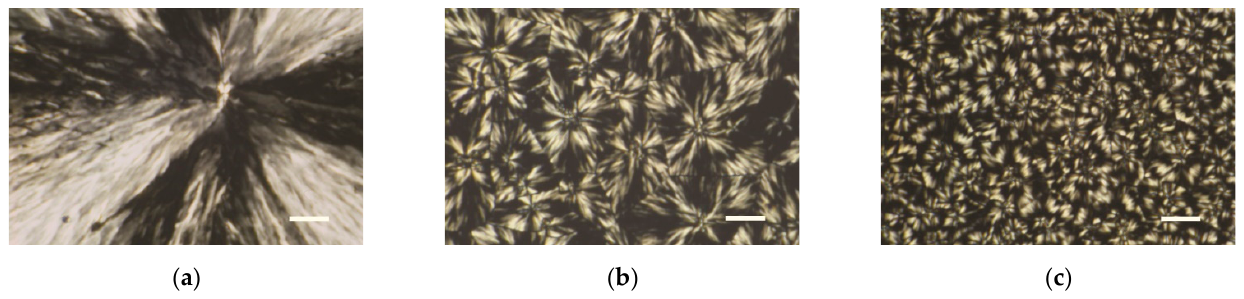
Figure 7. PLOM micrographs of ( a ) EPE(F38), ( b ) CUC1, and ( c ) CUC5 crystallized at 35 °C. Scale bar is 100 μ m.